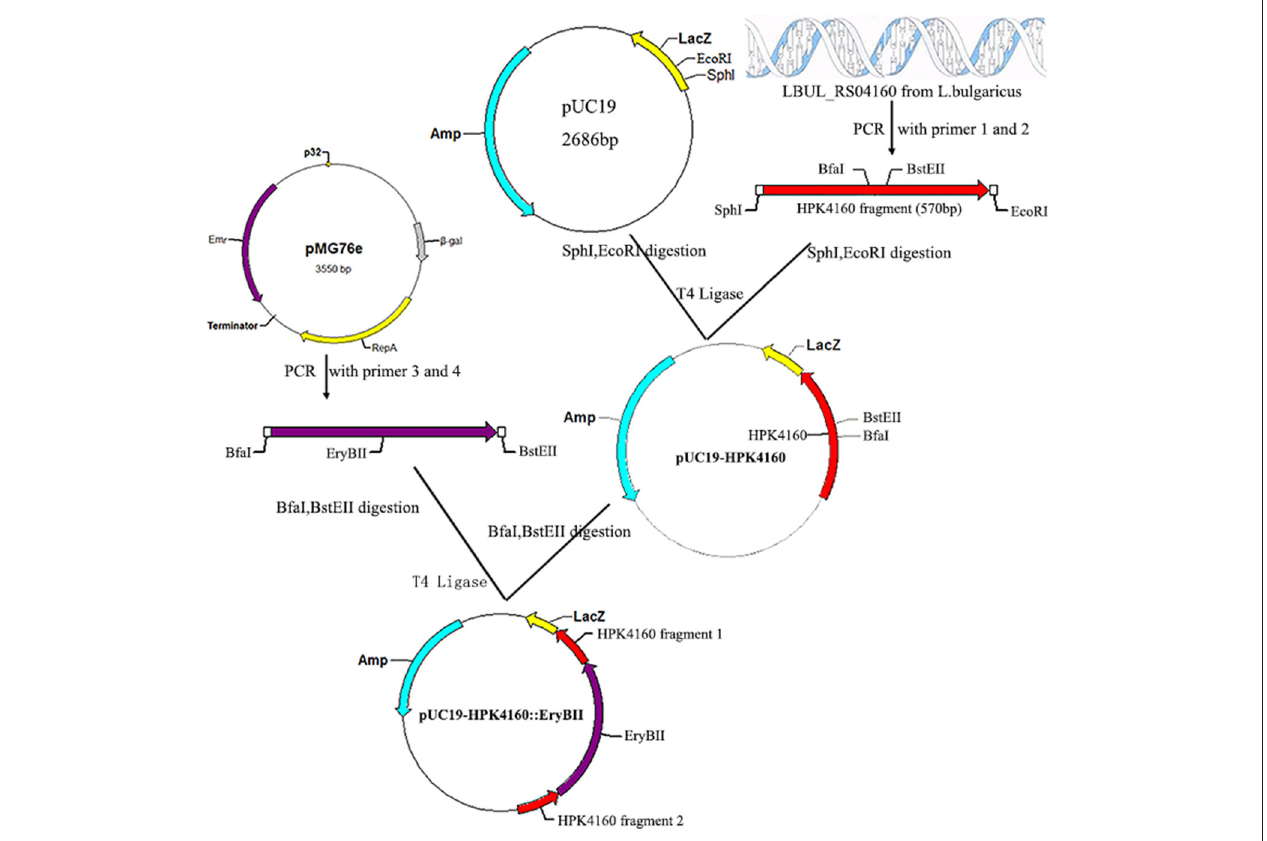
FIGURE 1 | Construction of recombinant plasmid pUC19-HPK4160::EryBII. The red arrow represents the HPK4160 gene from L. bulgaricus ATCC BAA-365; The cyan arrow represents the ampicillin resistance gene; The purple arrow represents the erythromycin resistance gene; SphI, EcorI, BfaI, BstEII are four endonuclease hydrolysis